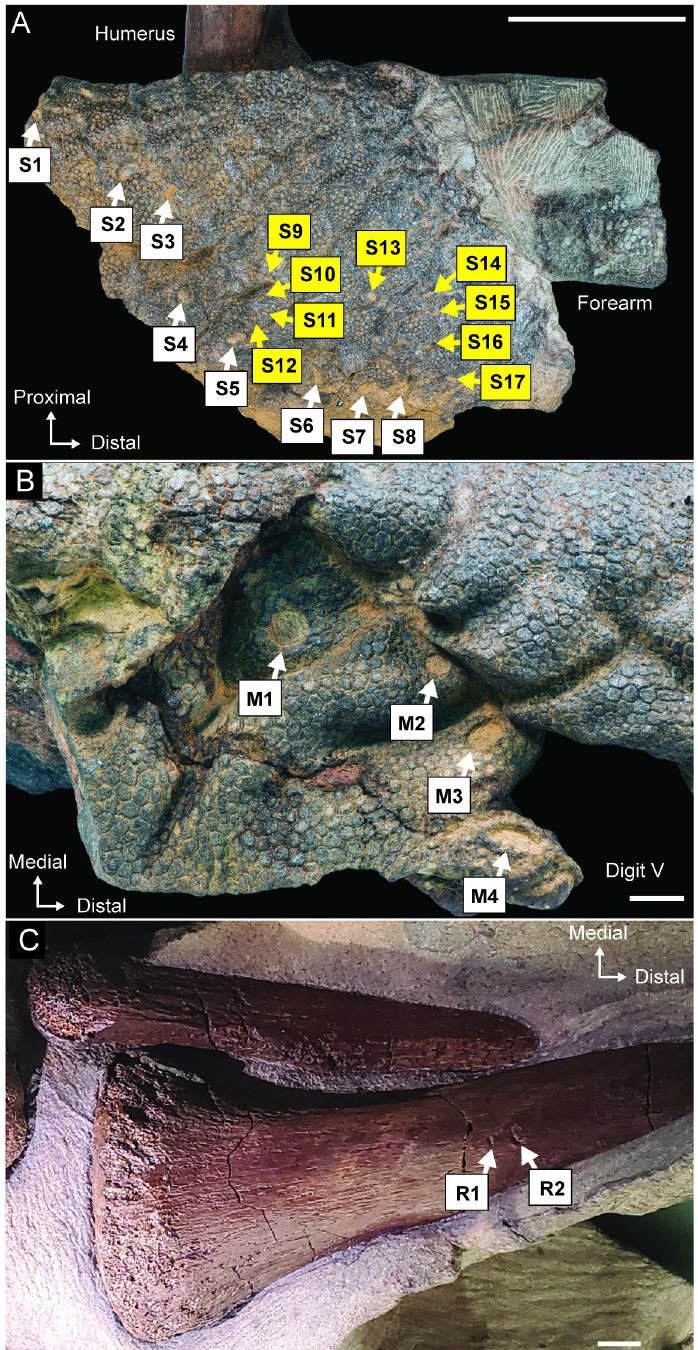
Fig 7. Locations of measured feeding traces on NDGS 2000 provided in Table 1. (A) Right lateral view of right elbow region. Coloration of arrows corresponds with that defined in Fig 5. (B) Dorsal view of manual digit V. (C) Proximal portion of right radius in anterolateral view. Scale bar in A equals 10 cm, scale bars in all others equal 1 cm.